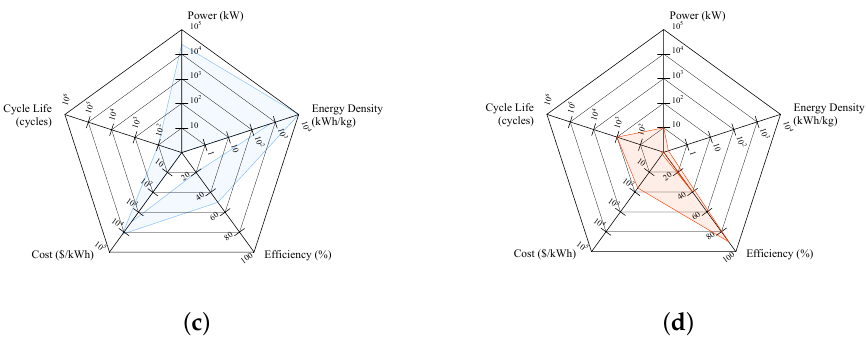
Figure 4. Comparison of the reported performance of the main attributes of different energy storage systems. The colored area represents the range between the best- and worst-case scenario reported in the literature per attribute. Note that the increases in the graphs are on a logarithmic scale in all attributes but the efficiency. ( a ) Reported performance of Li-ion batteries [126,139,140]. ( b ) Re- ported performance of supercapacitors [126,139,140]. ( c ) Reported performance of hydrogen fuel cells [126,139,140]. ( d ) Reported performance of thermal energy storage [140–144]. The power on this graph represents the heat transfer rate.